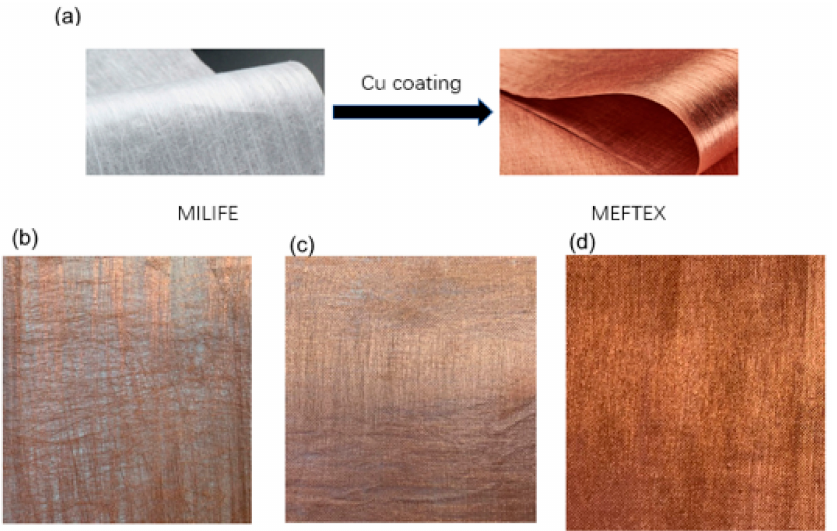
Figure 4. ( a ) Copper coating the PES fabric “MILIFE”, resulting in “MEFTEX” sample; ( b ) MEFTEX from MILIFE sample with areal weight 10 g/m 2 ; ( c ) MEFTEX 20 g/m 2 ; ( d ) MEFTEX 30 g/m 2 . Image sizes are 20 cm × 20 cm. From [60], copyright (2021), the authors.